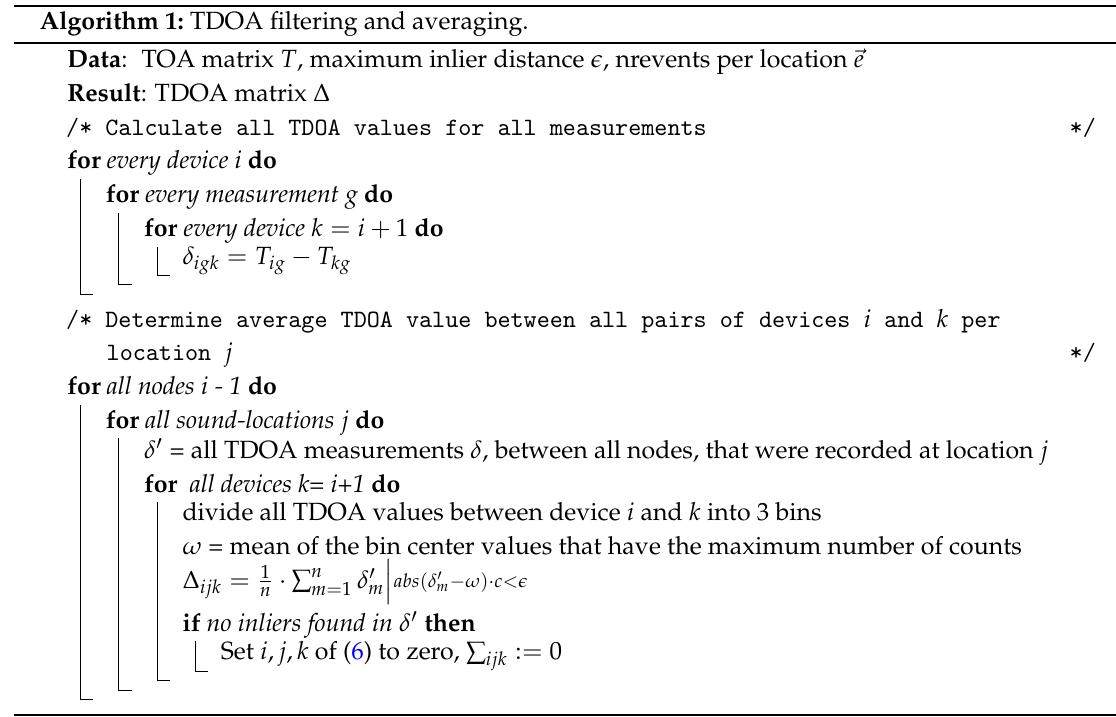
Figure 3 denotes the outline of the CLASS algorithm. The algorithm first averages TDOA values